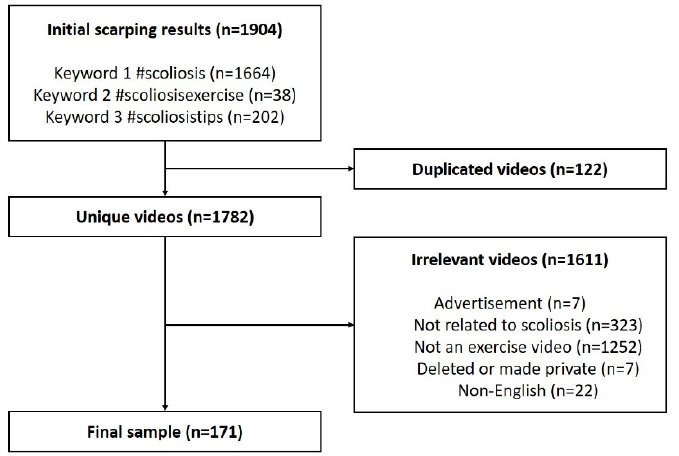
Figure 1. Flowchart of the search process for videos related to scoliosis exercises.